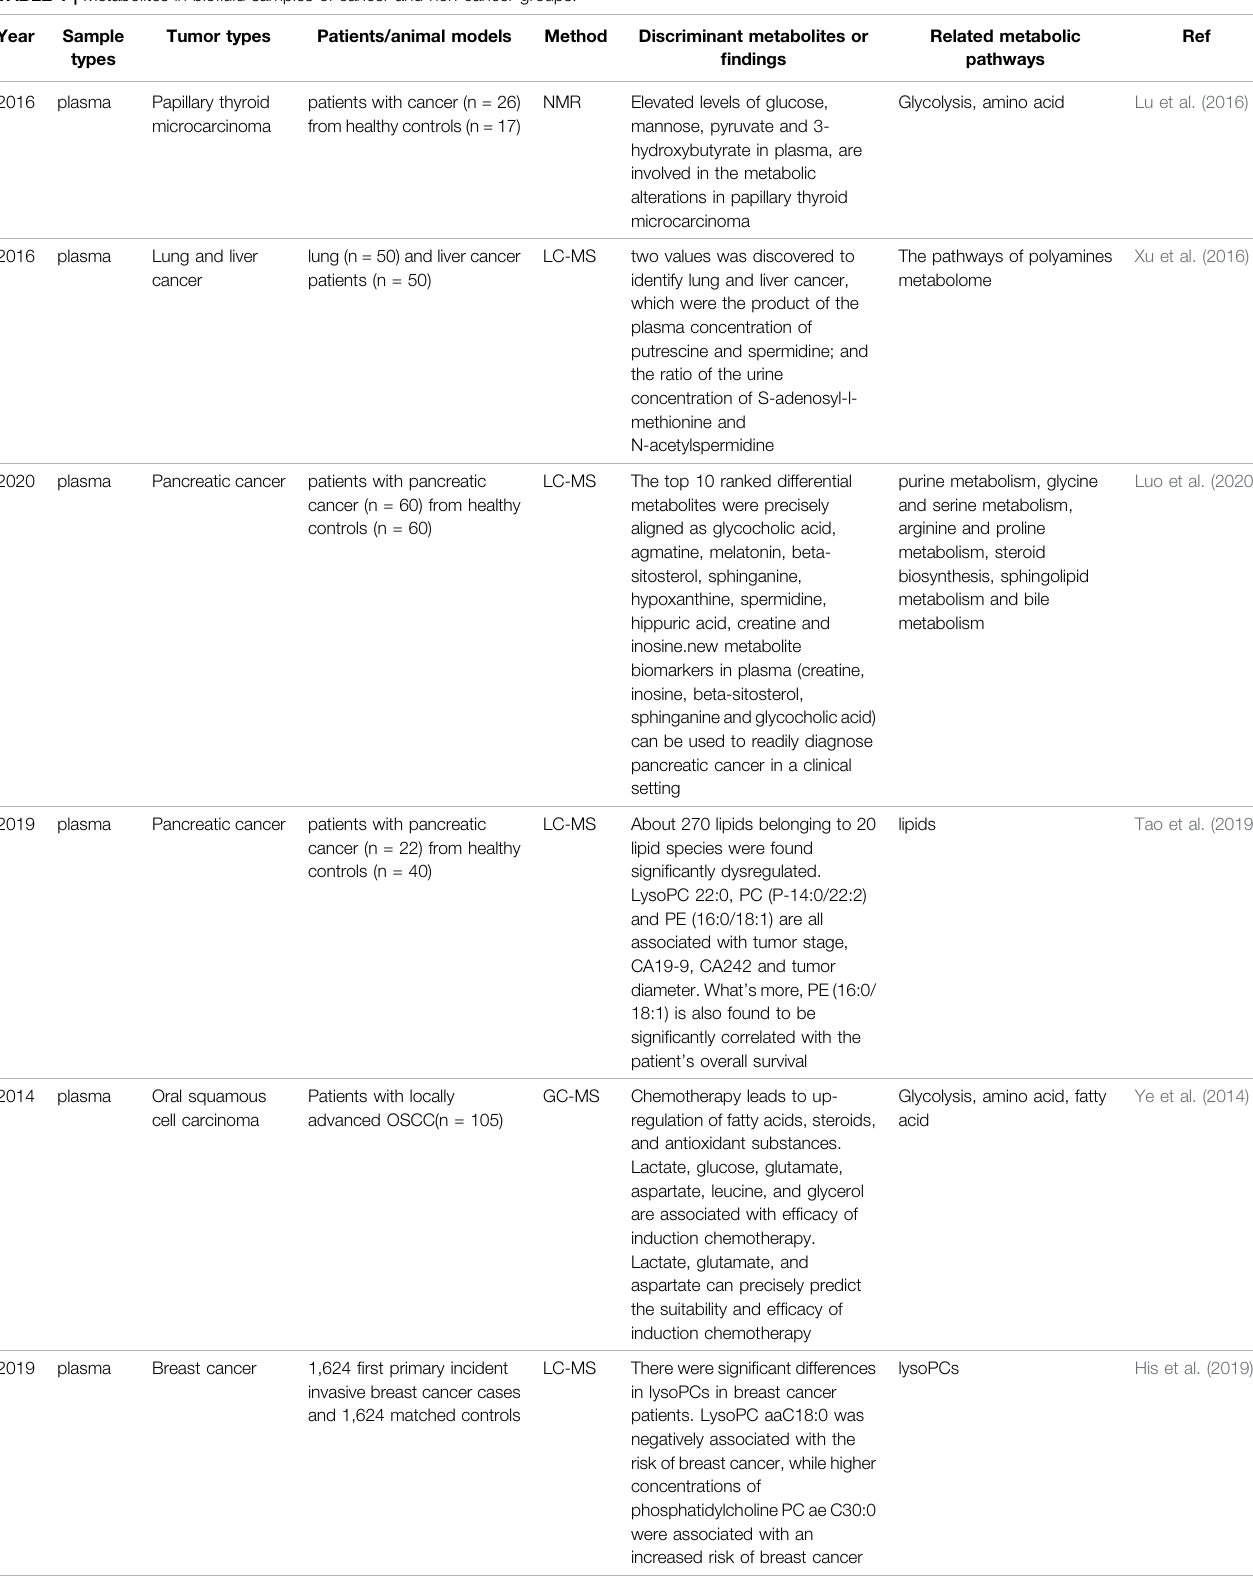
TABLE 1 | Metabolites in bio fl uid samples of cancer and non-cancer